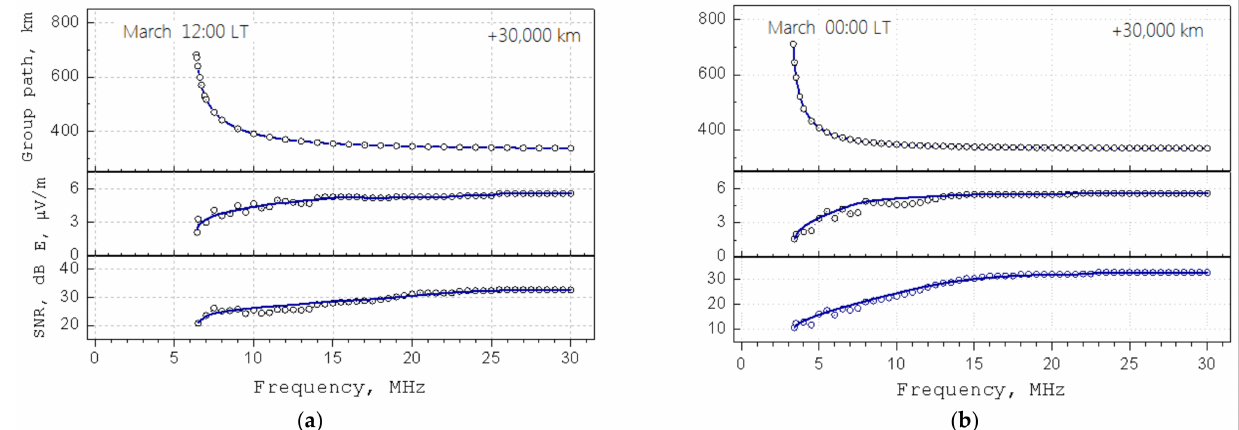
Figure 4. Synthesized transionograms (some topside equivalence of an OIS) on the meridional radio path (quasi-longitudinal propagation) with energy parameters: wave field strength and signal-to-noise ratio. Curve lines reflect the smoothed results. ( a ) illustrates the data for local noontime, and ( b ) for local